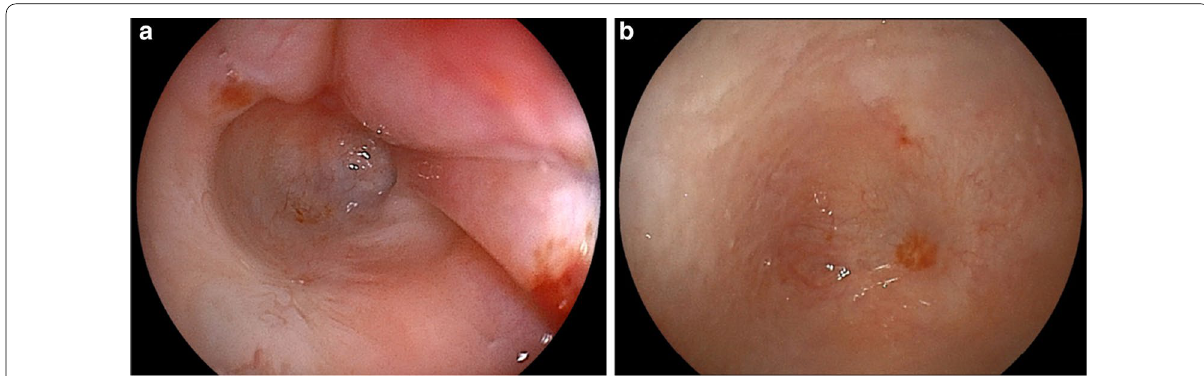
Fig. 5 Esophagoscopy findings. a Esophagoscopy revealing a blind end—26 cm from the incisors—in the middle thoracic esophagus, similar to that in congenital esophageal atresia, at approximately 10 months after diagnosis. b Esophagoscopy via gastrostomy revealing a blind end in the lower thoracic esophagus, at approximately 2 years after